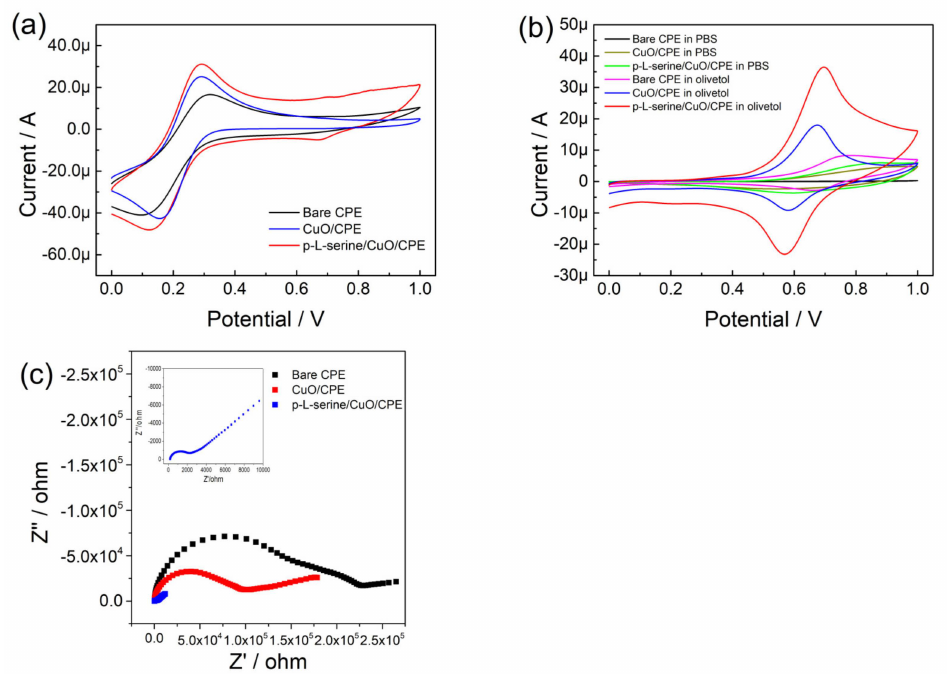
Figure 3. ( a ) CV curves of potassium ferricyanide on bare CPE, CuO/CPE, and p-L-serine/CuO/CPE; ( b ) CV curves of PBS solution and olivetol on bare CPE, CuO/CPE, and p-L-serine/CuO/CPE; ( c ) Nyquist plots of bare CPE, CuO/CPE, and p-L-serine/CuO/CPE. The EIS plots of bare CPE, CuO/CPE, and p-L-serine/CuO/CPE were investigated to find the change of charge transfer resistance (Rct) of electrodes during